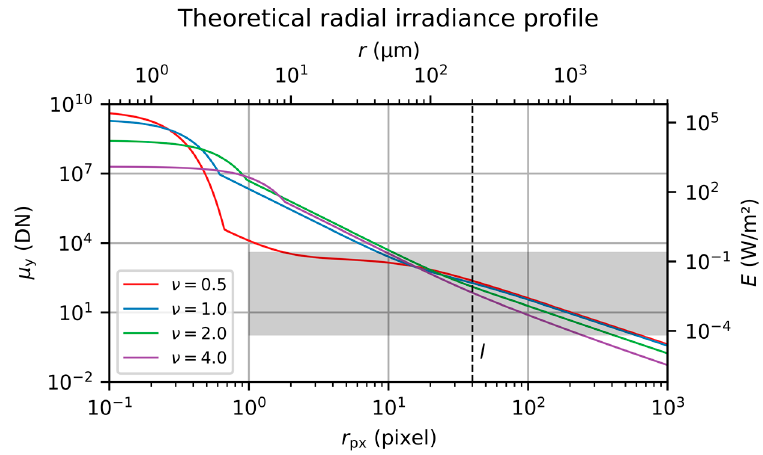
Figure 3. Theoretical radial irradiance profile for different values of truncation factor 𝜈 .